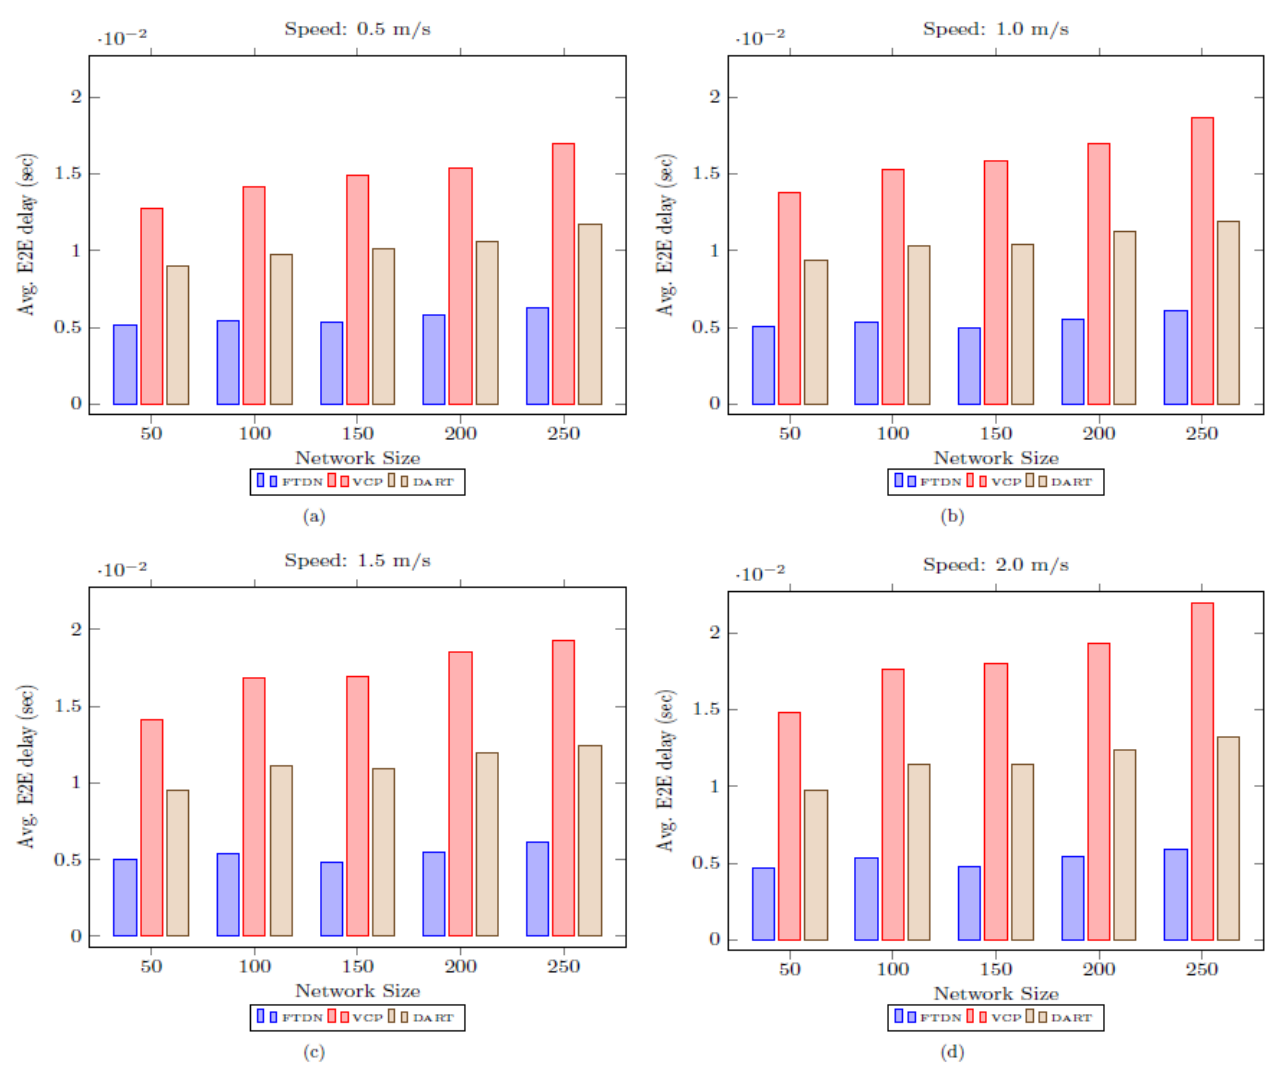
Figure 7. Average E2E lookup delay as a function of network size and speed. Figure 8 provides E2E delay comparison using boxplots against different nodes speed with varying network size. The data distribution further endorses FTDN’s significant